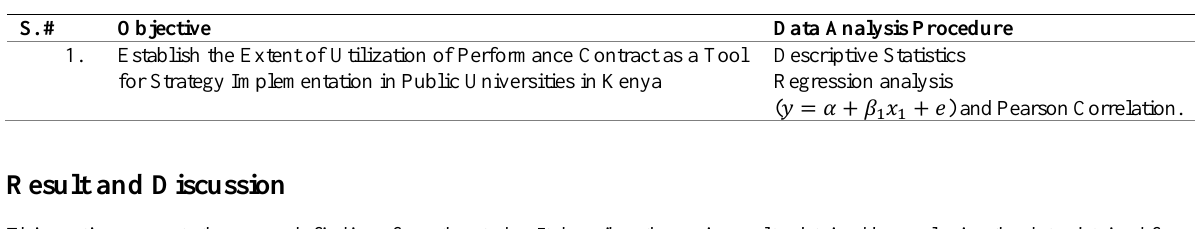
Table 2: Data Analysis Summary Table